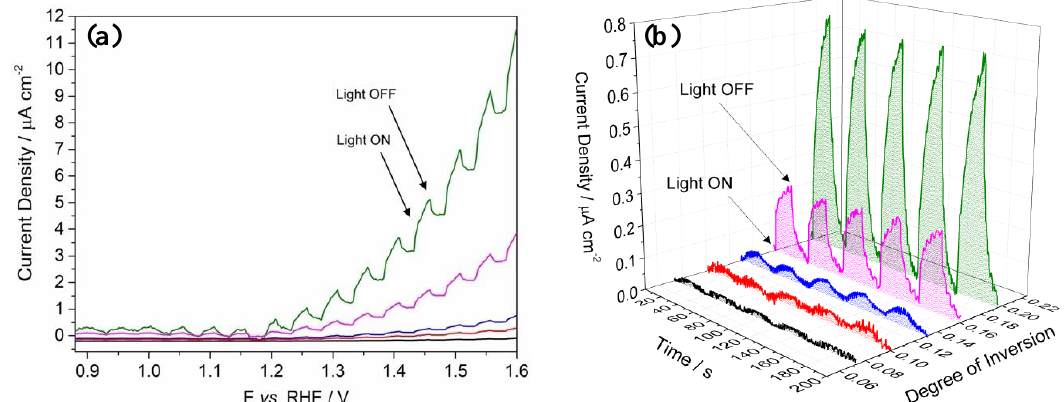
Figure 1. ( a ) Current density − voltage curves for the photoanodes made from ZFO pellets with different degrees of inversion. The measurements were performed in a 50% v/v methanol aqueous solution containing 0.1 mol L −1 KNO 3 under chopped solar simulator irradiation (intensity output of 680 W m −2 ). The light was turned on and off at 20 second intervals. ( b ) Chopped light chronoamperometry for the ZFO photoanodes measured with an externally applied bias of +1.2 V vs . RHE. x = 0.074 (ZFO_773); x = 0.104 (ZFO_873); x = 0.134 (ZFO_973); x = 0.159 (ZFO_1073); and x = 0.203 (ZFO_1173).